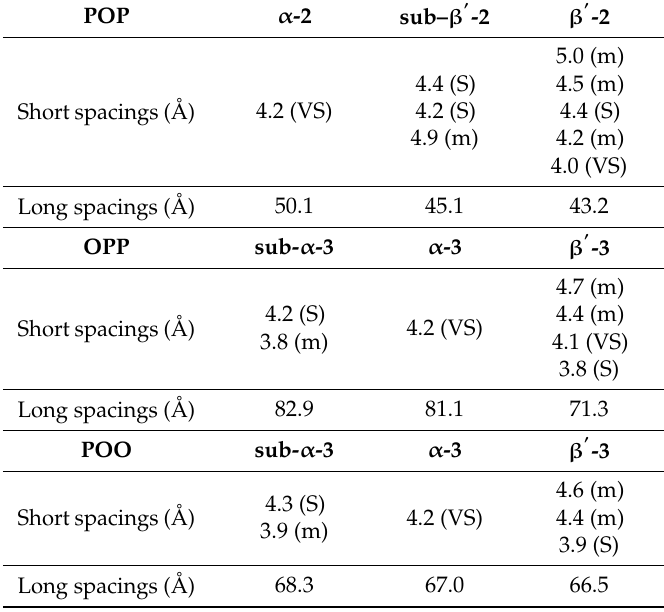
Table 3. Short and long spacings observed for POP, OPP and POO in direct mode (m: medium intensity; S: strong intensity; VS: very strong